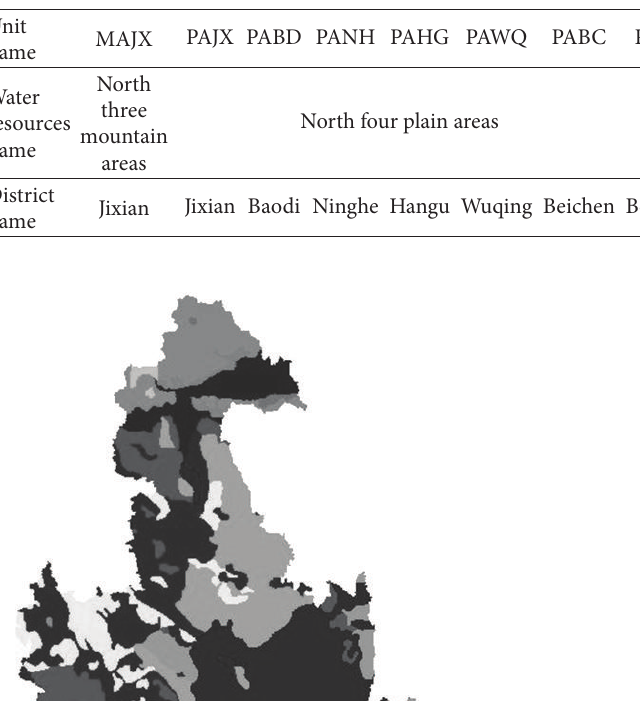
Table 2: The delineated subzones of Tianjin in AWOM.